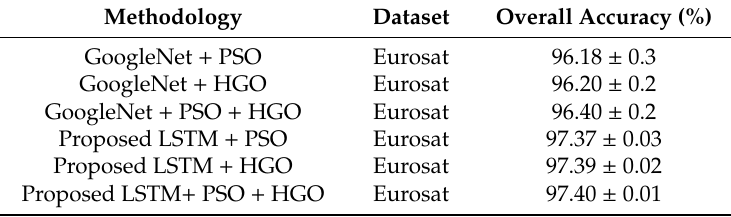
Table 15. Comparative analysis of proposed LSTM with PSO and HGO on the Eurosat dataset.